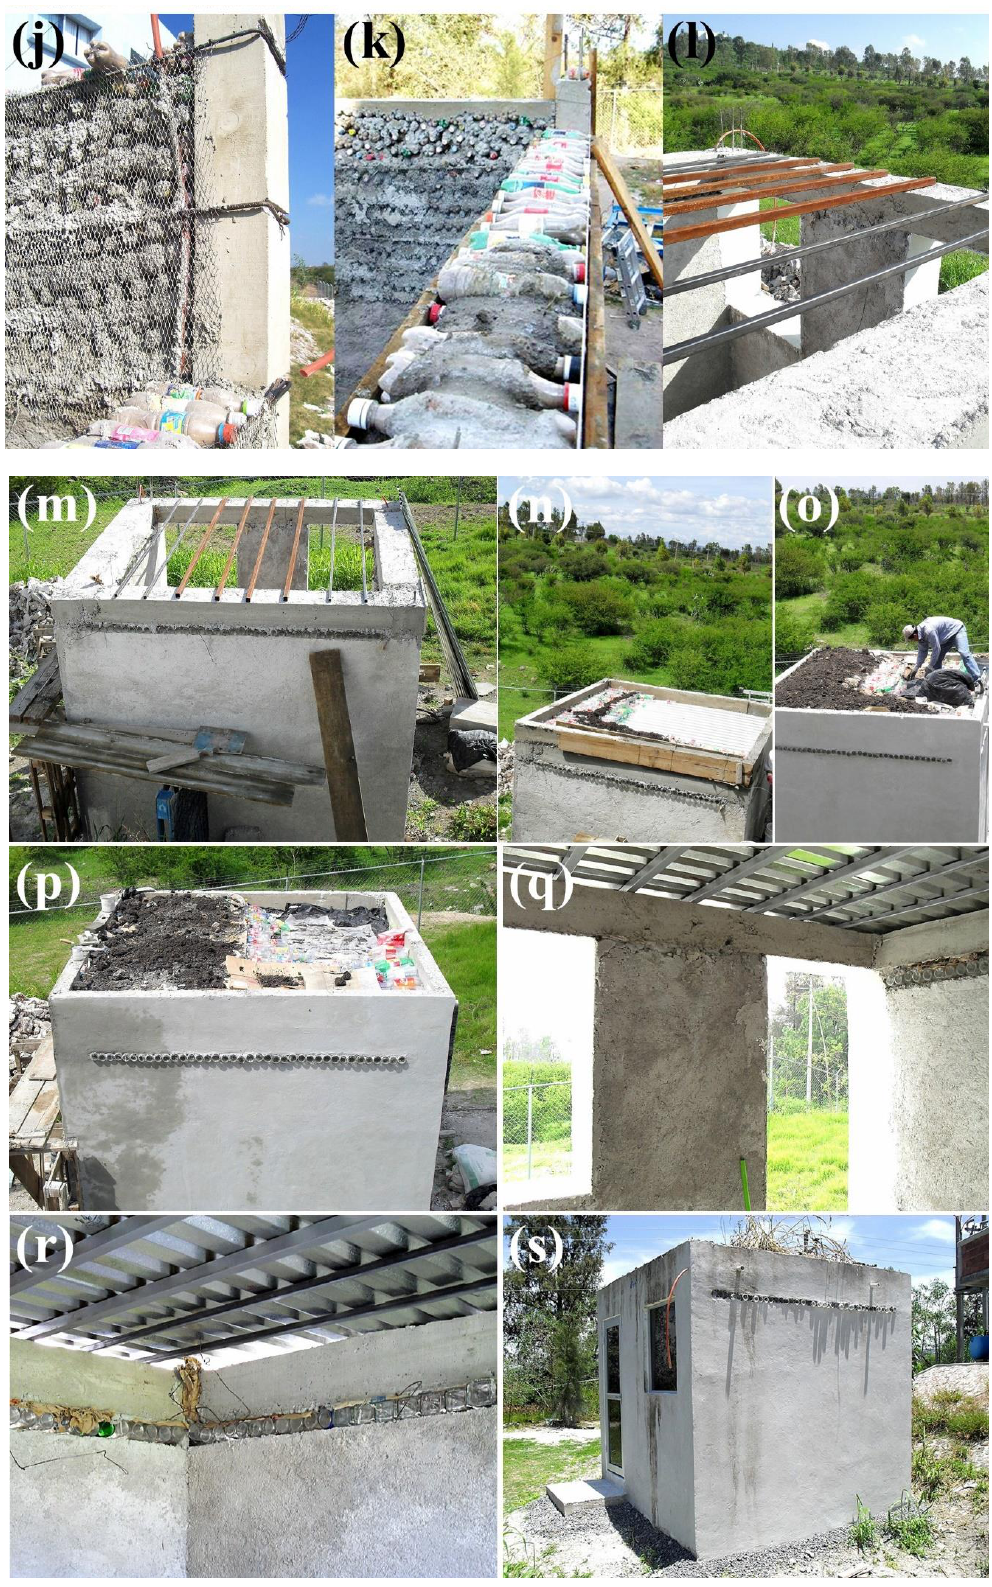
Figure 4. (a – s ) Images of the building process for the housing prototype using PET bottles.